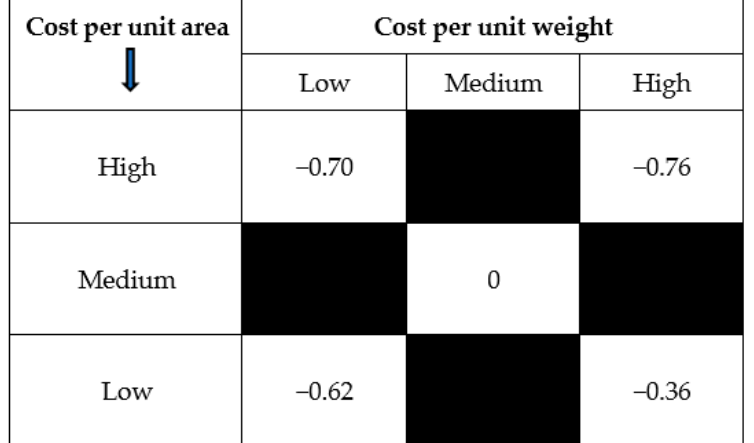
Figure 2. Variations in inventory holding costs of Organization A.